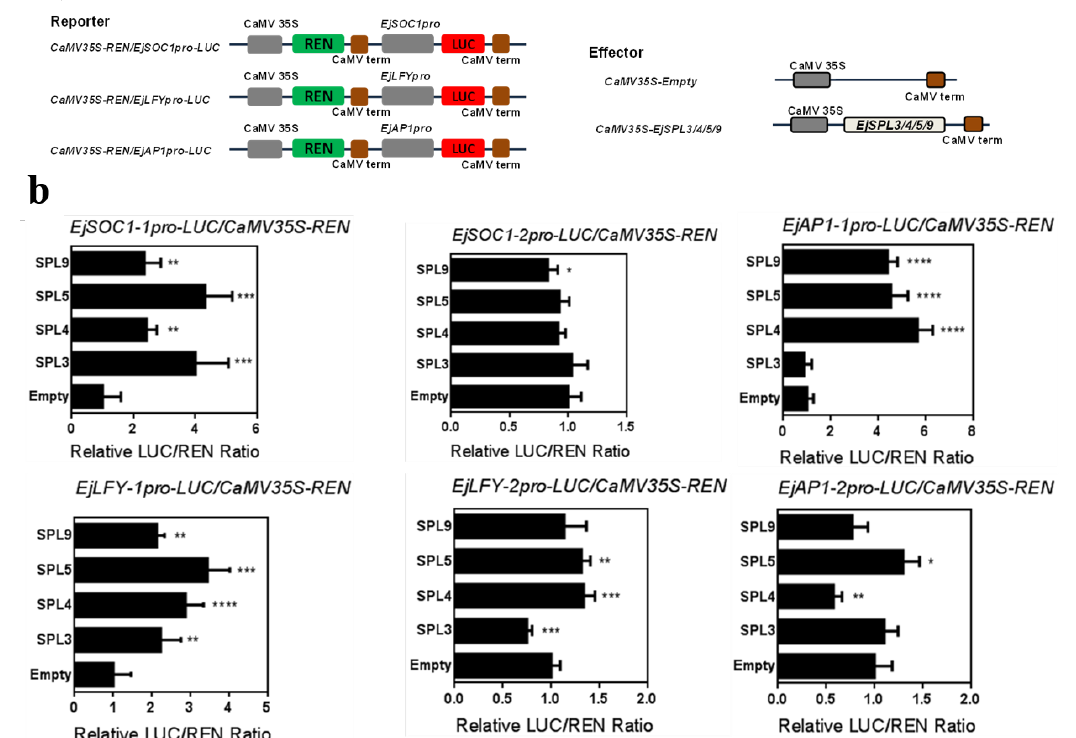
Figure 7. The activation of EjSPL3 , EjSPL4 , EjSPL5 and EjSPL9 on the expression of EjLFY , EjAP1, and EjSOC1 . The activation effect was detected using dual luciferase system. ( a ) Vectors construction. ( b ) EjSPL3 , EjSPL4 , EjSPL5, and EjSPL9 activated the EjLFY , EjAP1, and EjSOC1 promoters. Error bars indicating SE from at least six biological replicates. The asterisk indicates a significant difference compared to the empty effector (Student’s t -test, * p < 0.01, ** p < 0.001, *** p < 0.0001, **** p < 0.00001).